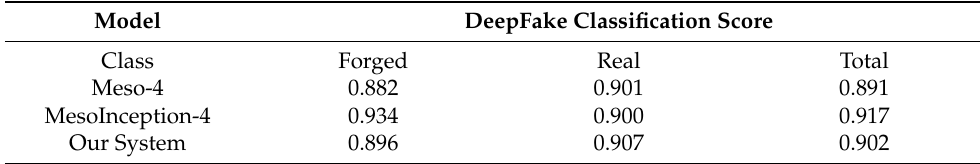
Table 4. DeepFake Dataset classification scores.